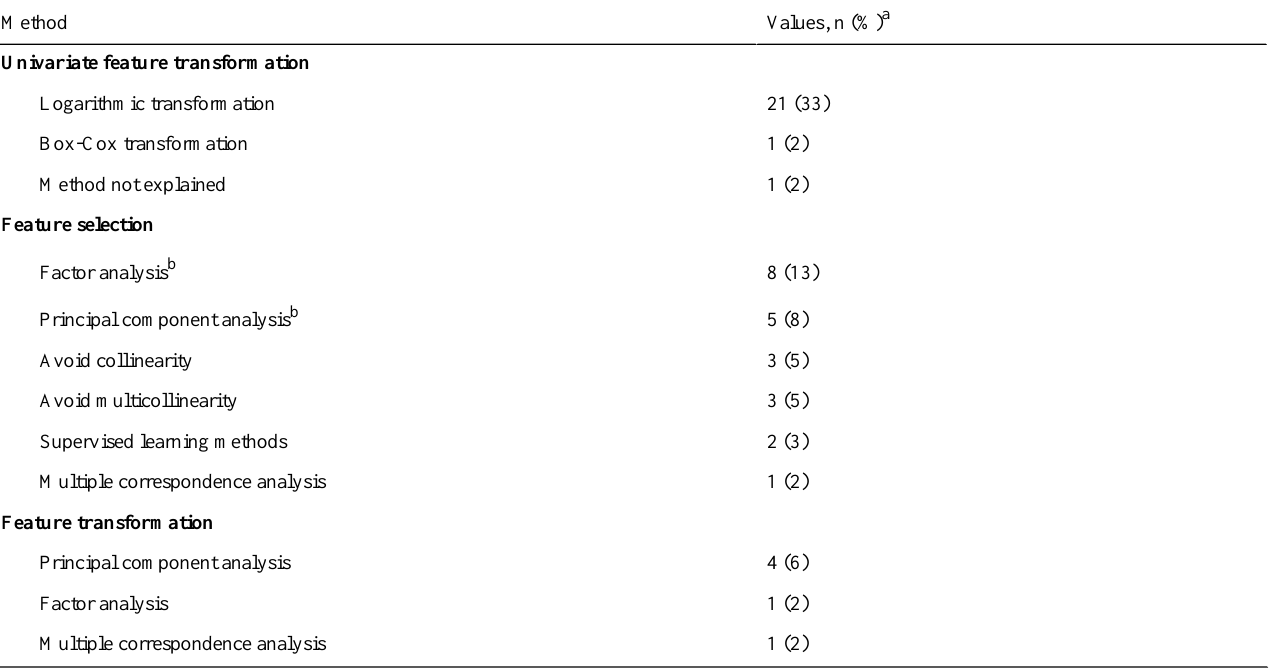
Table 5. Feature engineering methods used in the asthma studies included in this